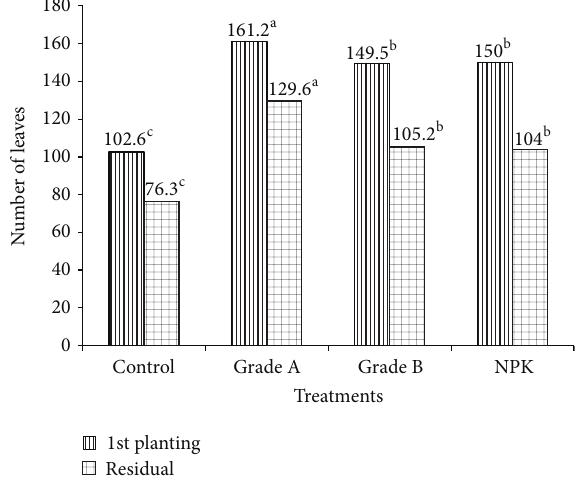
Figure 2: Number of leaves of Amaranthus caudatus as influenced by application of organic fertilizers and NPK at 4 weeks after trans- planting. Means having the same letter along the columns indicate no significant difference using Duncan’s multiple range test at 5% probability